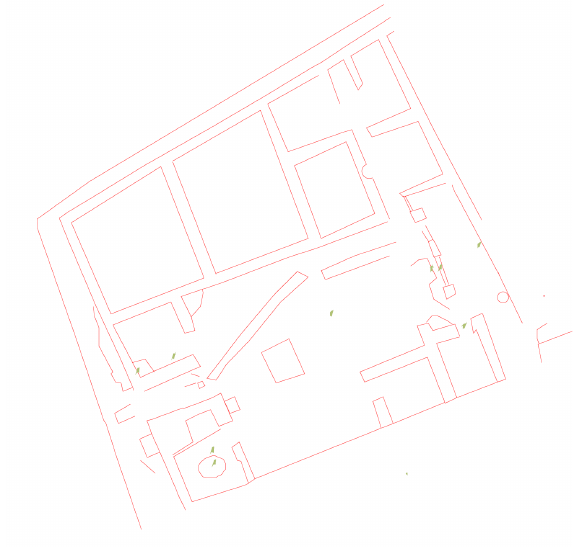
Figure 3. Planimetry of Domus of Stallius Eros - Elaboration by total station and